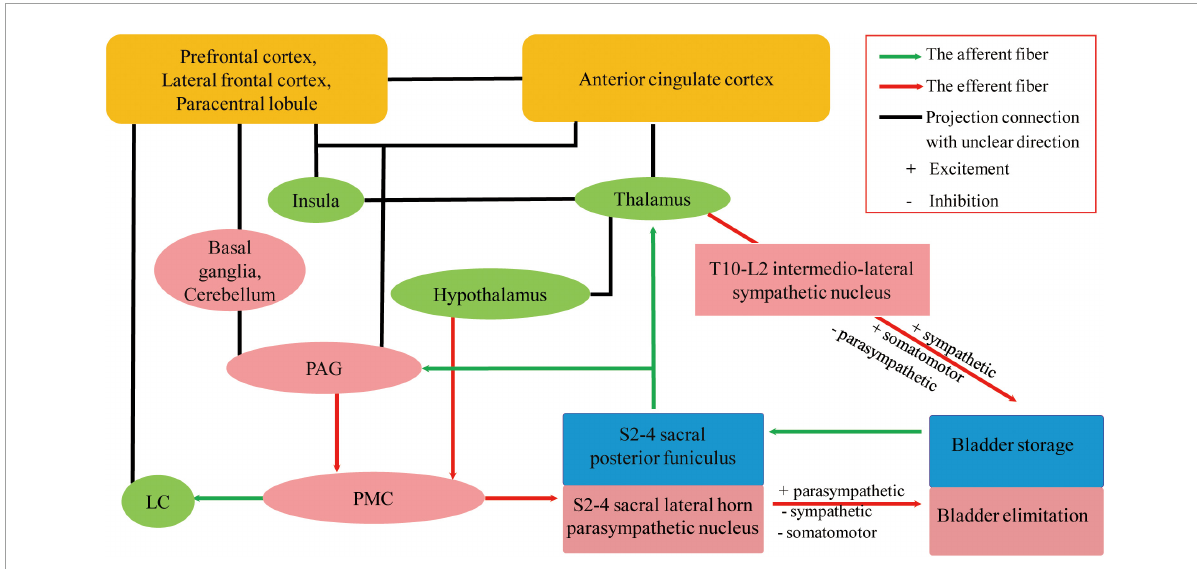
FIGURE2 Possible neural circuits that coordinate urine storage and elimination (Fowler et al., 2008; Perneczky et al., 2008; Valentino et al., 2011; Griffiths, 2015; Hou et al., 2016; Merrill et al., 2016; Elman et al., 2021; Xiao et al., 2022). Part of the projection in the neural control of micturition is modified from Fowler et al. (2008), reproduced with permission from Springer Nature and Copyright Clearance Center. UD, urinary dysfunction; VCI, vascular cognitive impairment; PAG, periaqueductal gray; PMC, pontine micturition center; LC, locus